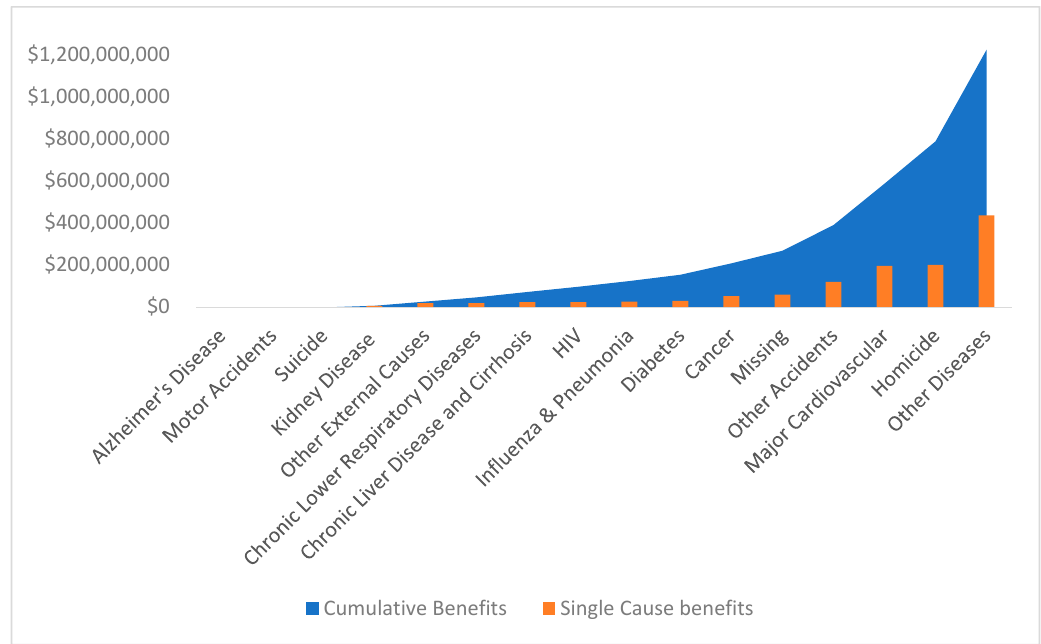
Figure 2. Annualized economic benefits for saved lives (2011–2015), lower bound. Table 3. Weeks of work missed due to illness, ages 16–65